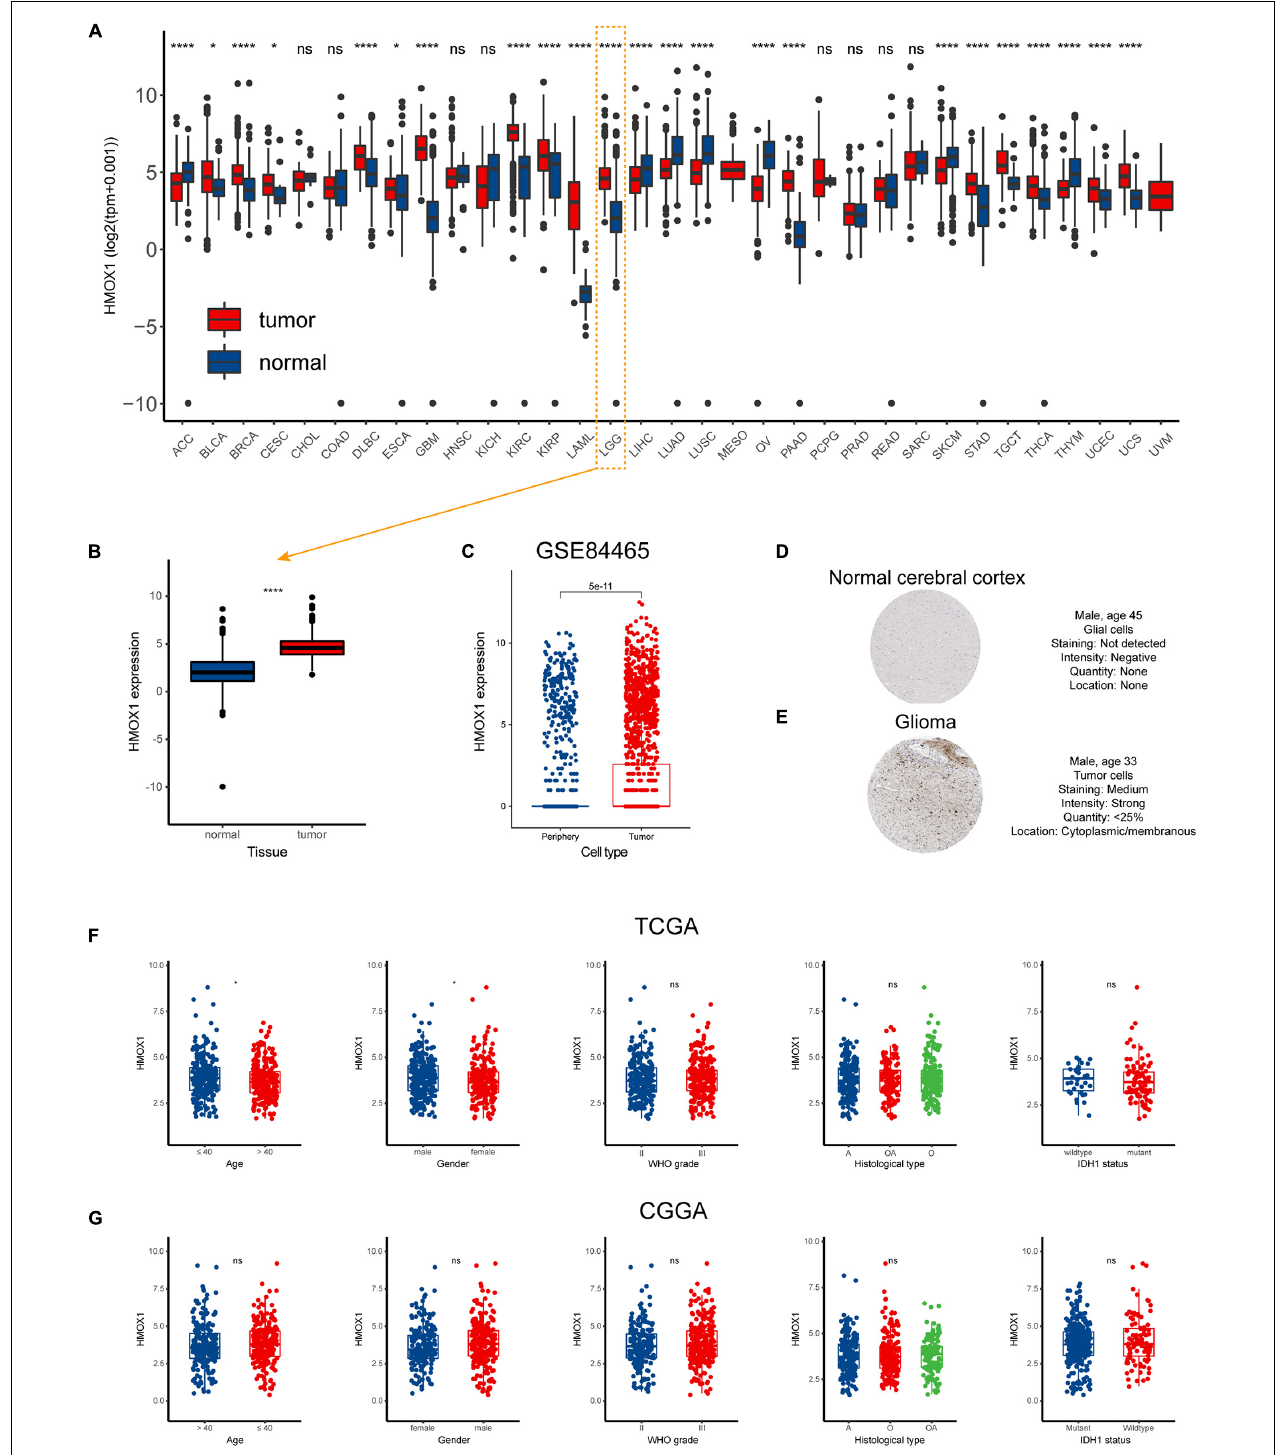
FIGURE 1 | Expression profiles of HMOX1 in human normal and cancer tissues. (A) HMOX1 expression levels in TCGA pan-cancers. (B) HMOX1 mRNA expression levels in LGG and normal brain tissues. (C) HMOX1 mRNA expression levels in tumor and periphery single cells in GSE84465 cohort. (D,E) Representative IHC images of HMOX1 protein expression in normal cerebral cortex and glioma. (F,G) The HMOX1 expression of different subgroups for age, gender, WHO grade, histological type, and IDH1 status in the TCGA and CGGA cohorts. * p < 0.05, **** p < 0.0001, ns, not significant. A, astrocytoma; O, oligodendroglioma; OA, oligoastrocytoma; WHO, World Health Organization; IDH1, isocitrate dehydrogenase 1.